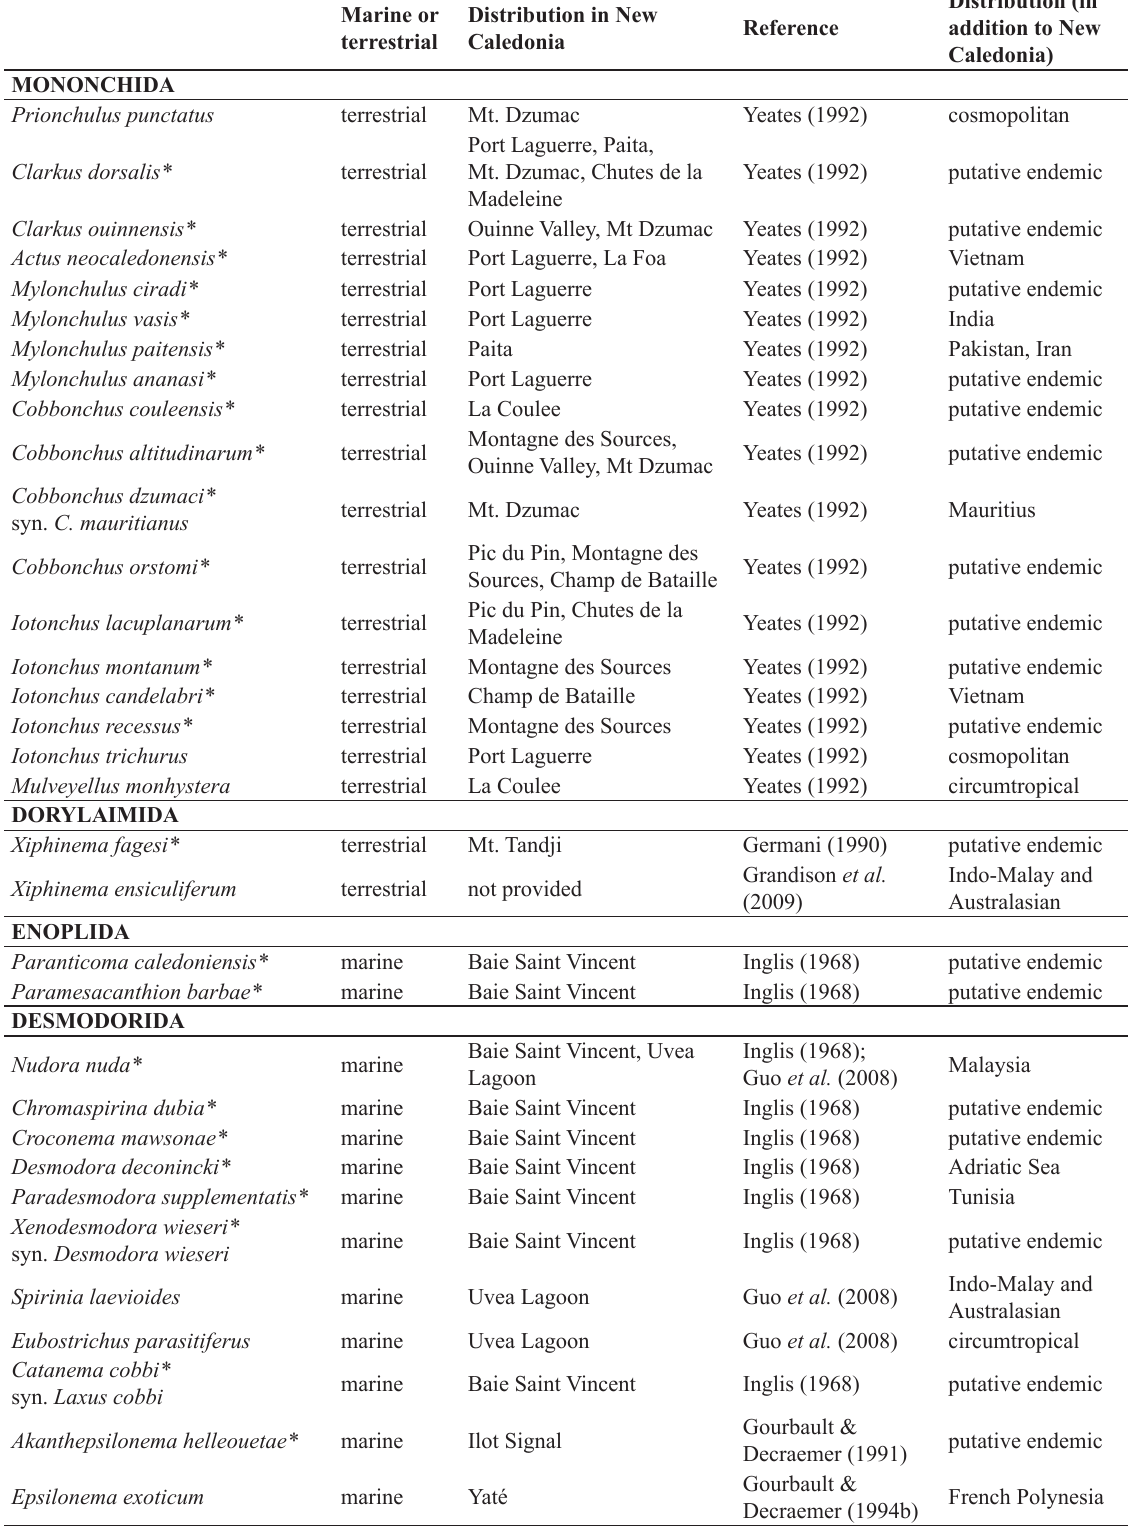
Table 1 . Free-living and plant-parasitic nematode fauna of New Caledonia (originally described from New Caledonia are marked with an